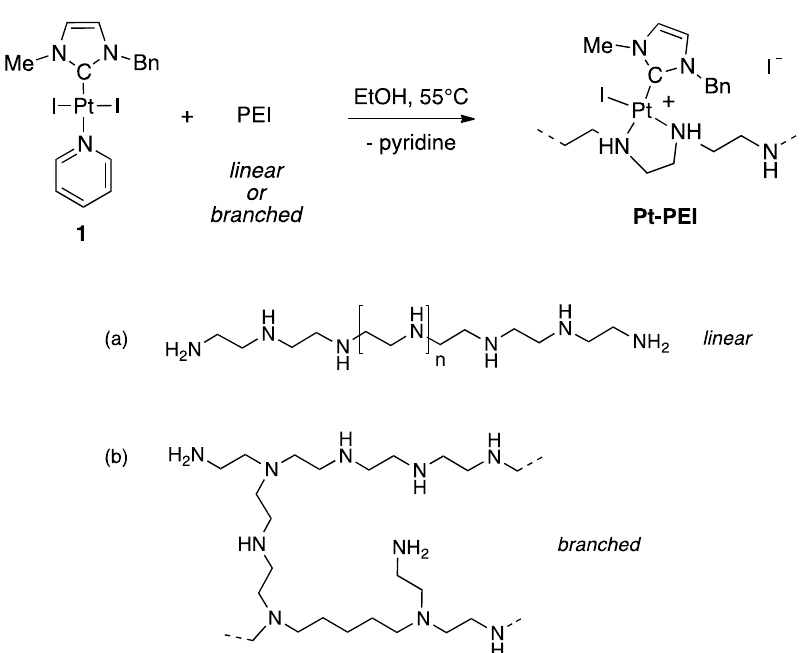
Figure 2. Synthesis of NHC-Pt-PEI conjugates prepared from trans [(NHC)PtI 2 (pyridine)] (1) (NHC = 3-benzyl-1-imidazolilydene) (EtOH, 55 °C, 48 h, quantitative). Chemical structure of ( a ) linear and ( b ) branched PEI.